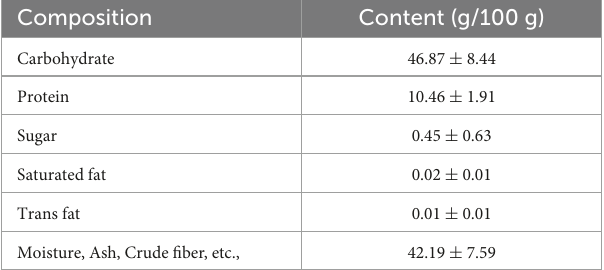
TABLE 2 Nutrition content of